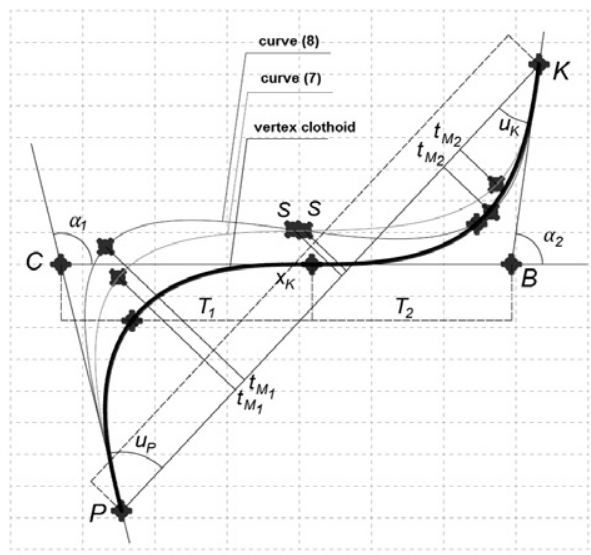
Figure 9. Reverse curves: symmetric vertex clothoids vs S -shaped transition curves (variant